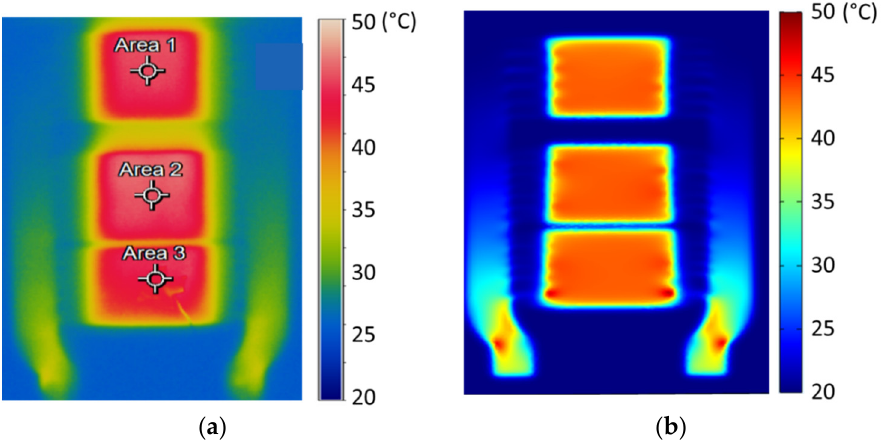
Figure 16. Heat map of ( a ) a real 3D-printed prototype using a thermal camera and ( b ) numerical model using COMSOL software. Table 10. Comparison between measured and theoretical temperatures of three heating areas.